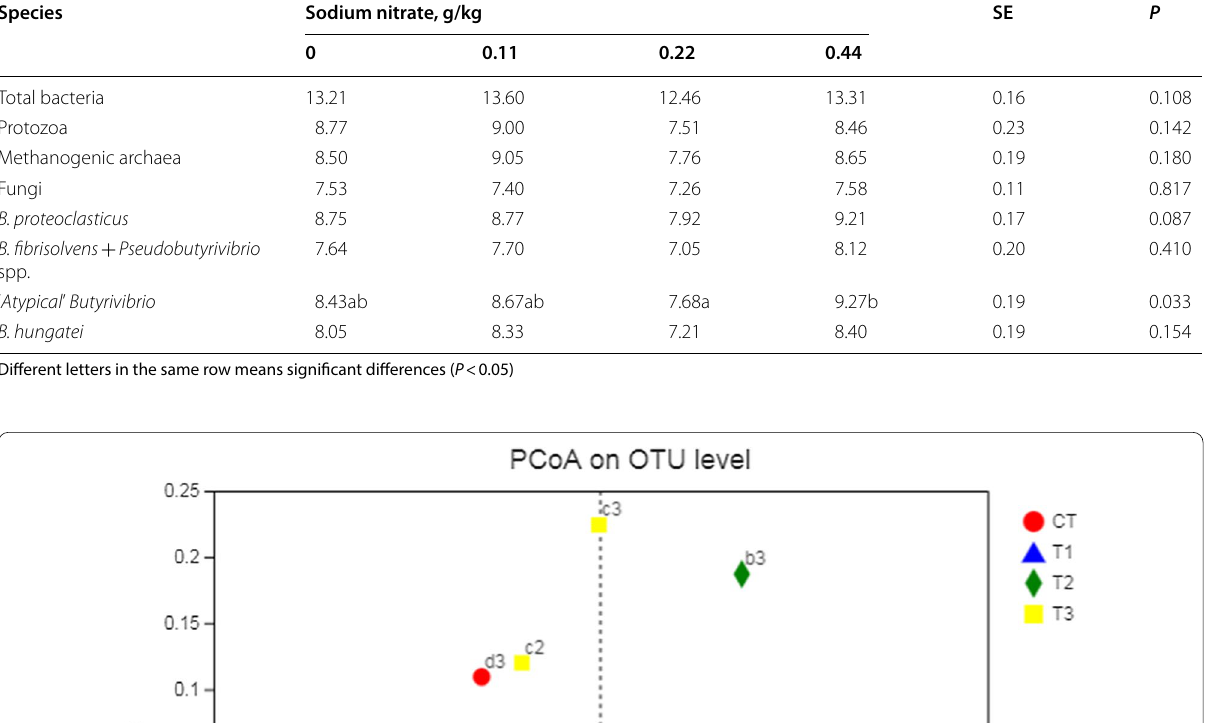
copies/g rumen contents) 10